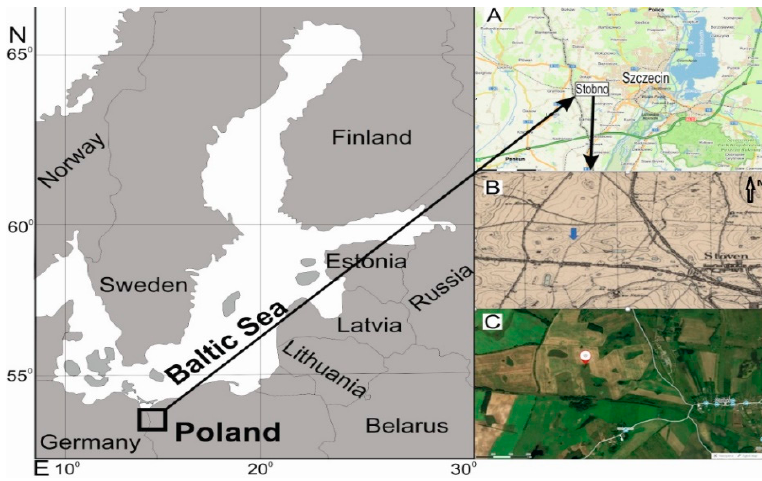
Figure 1. Location of the study area: ( A , C )—source of the photo: https://en.mapy.cz, ( B )— Meßtischblatt 2552, Kreckow, 1921, scale 1:25,000.